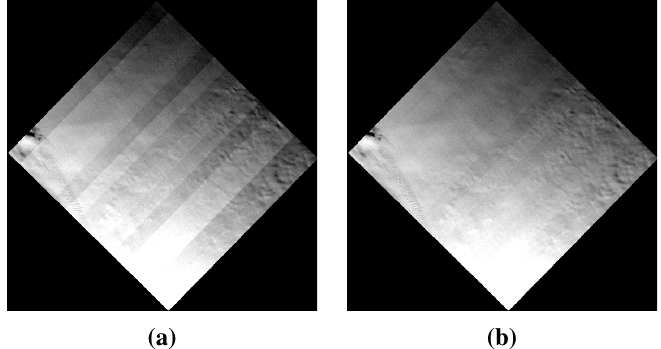
Figure 10. ( a )A sample coastal aerosol band image of Greenland, processed with the PSC gains and ( b ) with the PSC gains corrected for discontinuity. The random discontinuity effects (a) are converted to regular odd/even discontinuities (b) after the per-FPM gains were